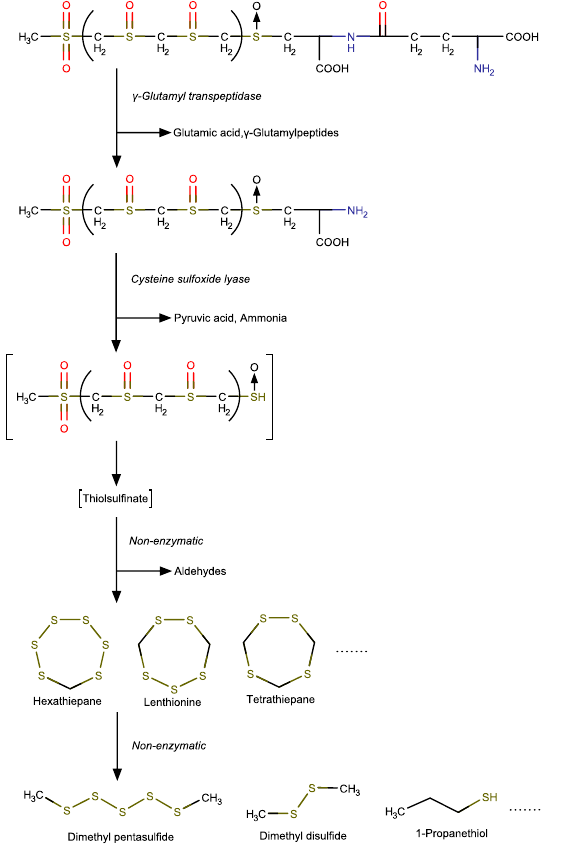
Figure 6. Mechanism of sulfur-containing heterocyclic compound changes through different enzyme- catalyzed and non-enzymatic